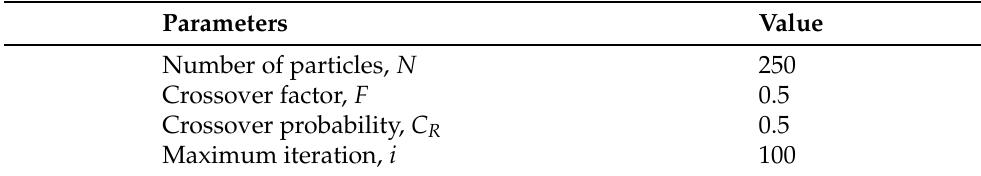
Table 1. PSO setup parameters for optimisation.